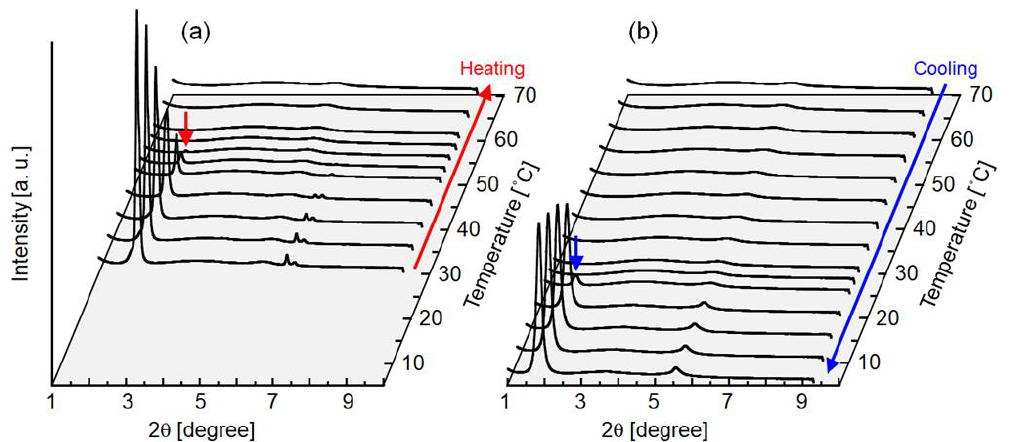
Figure 5. Small angle X-ray diffraction (SAXD) patterns of bulk palm oil used in this study recorded during ( a ) heating from 30 to 70 °C, and ( b ) cooling from 70 to 5 °C at a temperature variation rate of 2.5 °C/min. The short arrow on the peak at 2 θ = 1.9° in ( a ) indicates the disappearance of a lamellar crystalline peak, and that in ( b ) indicates the appearance of a lamellar crystalline peak (lamellar length = 42Å ).